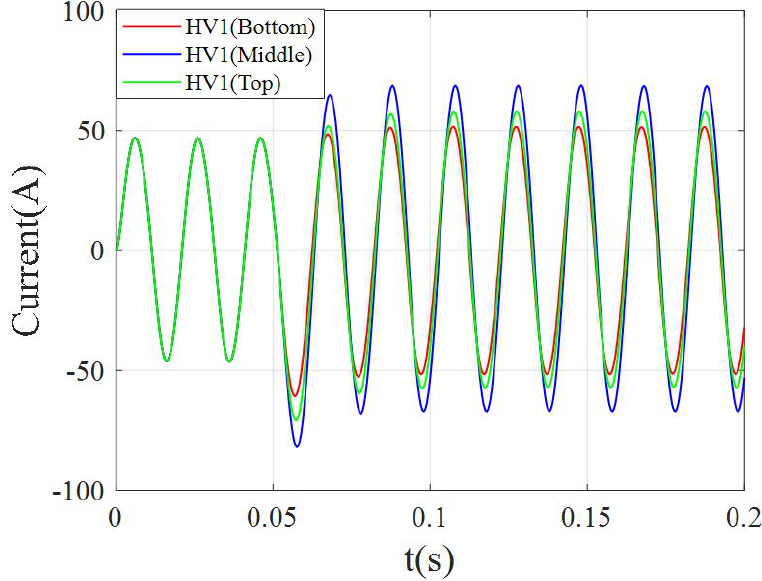
Figure 7. The current of HV1 winding under the TTFs at different positions. The peak current multiple and steady-state current multiple of each branch winding under the TTFs at different positions are shown in Tables 2 and 3, respectively. It can be seen that the current of HV1 is most affected because of the strong magnetic coupling between HV1 and LV1, while the peak current of HV1 is different under different faults. Hv4 and LV4 windings are greatly affected by the bottom short circuit fault. Because the short circuit position is close to HV4 and LV4 windings, the flux linkage generated by LV1 short circuit is offset by the flux linkage generated by HV1 and HV4 windings, which increases the current of HV1 and HV4 windings and decreases the current of LV4 windings. Table 2. The peak current multiple of each branch under different short-circuit positions. Location/Peak Current Bottom